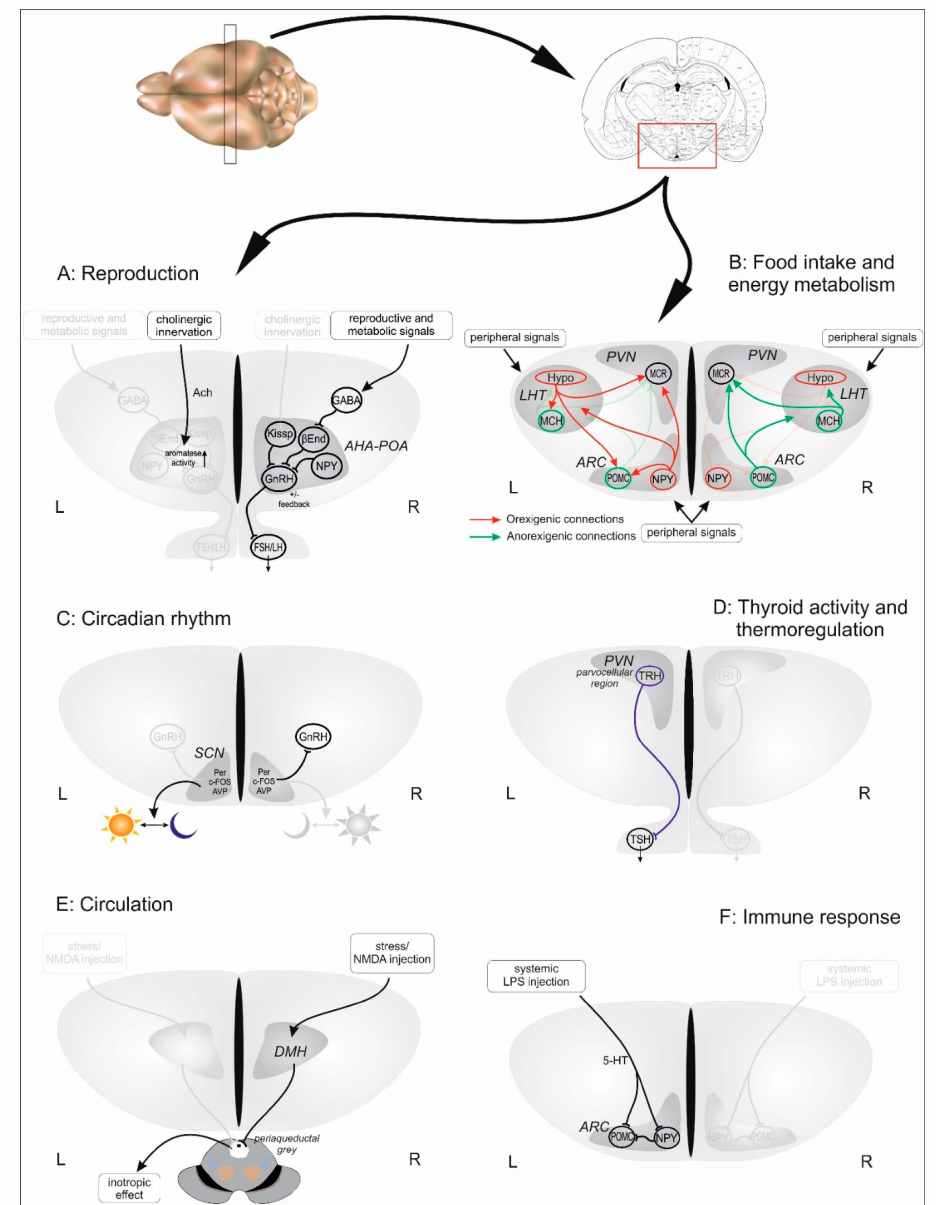
Figure 1. Task sharing of hypothalamic sides as far as it is suggested to date. Figures represent hypothalamic coronal sections, each attributed to a particular function discussed in the text. With regard to a control function those processes are depicted that have been described to be controlled in a lateralized manner. Mechanisms on dominant sides (left (L) or right (R)) are labelled with a brighter color while pale on the contralateral. Abbreviations: 5-HT: